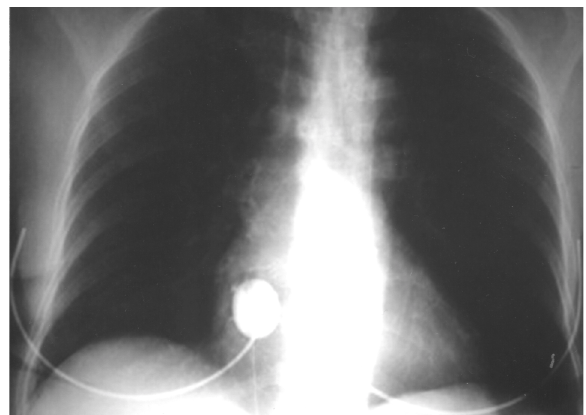
Figure 2 – Foley balloon in right atrium.